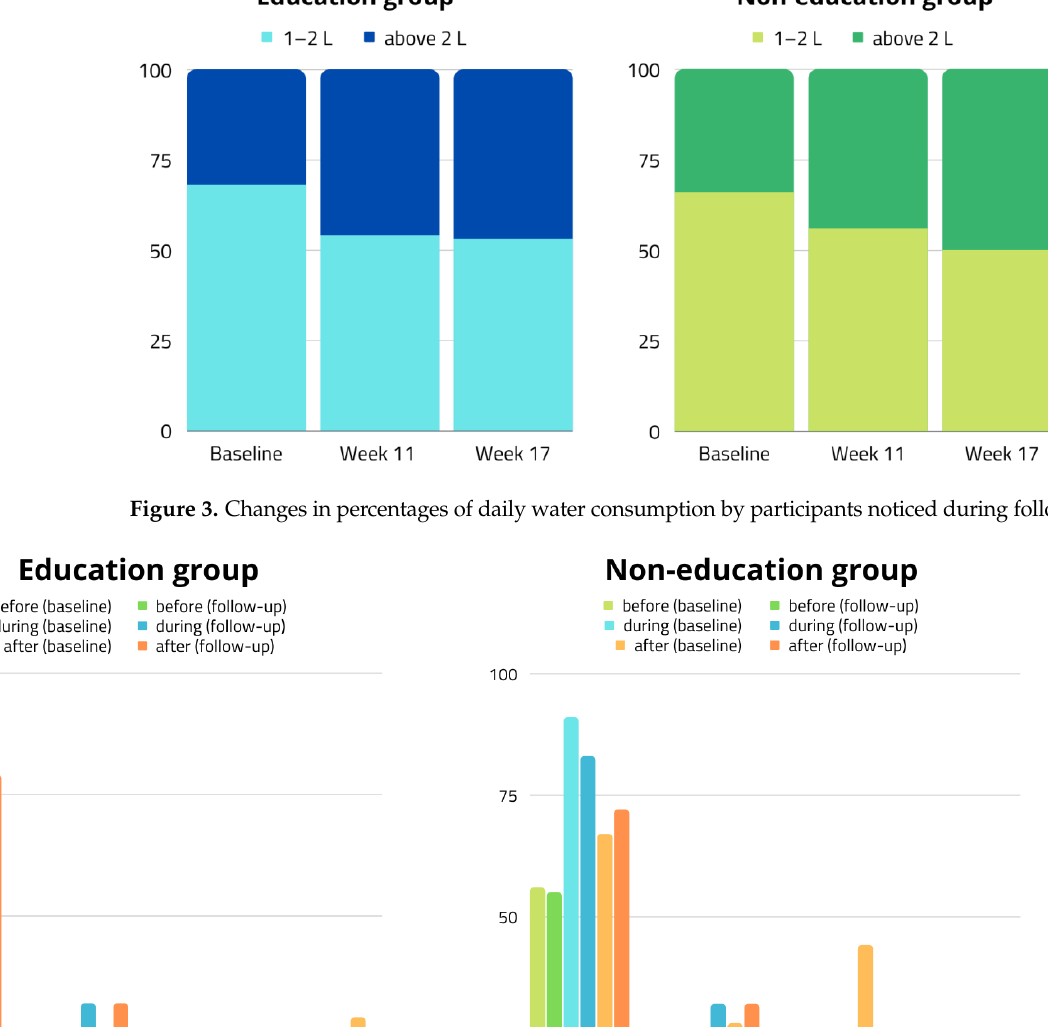
Figure 4. Percentage of participants ’ choices of peri-exercise fluid throughout the study.